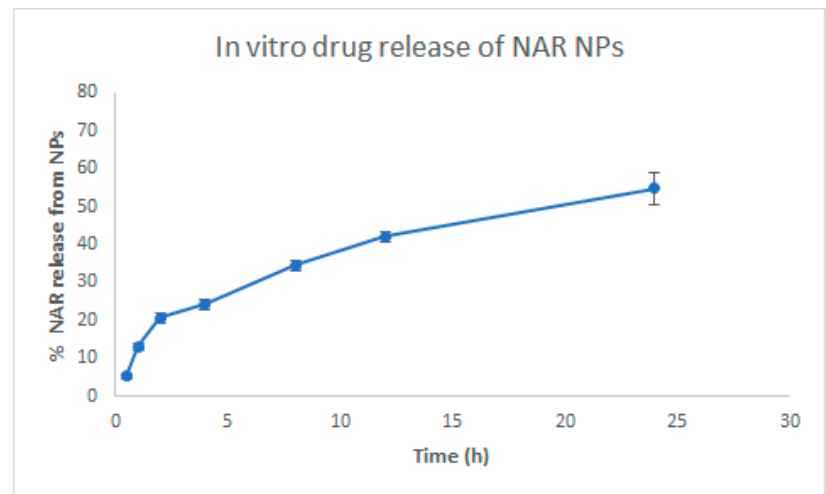
Figure 4. In vitro release studies of NAR NPs in release medium at pH 7.4 over 24 h. Values are expressed as mean ± SD ( n = 3), three independent experiments performed in triplicate.